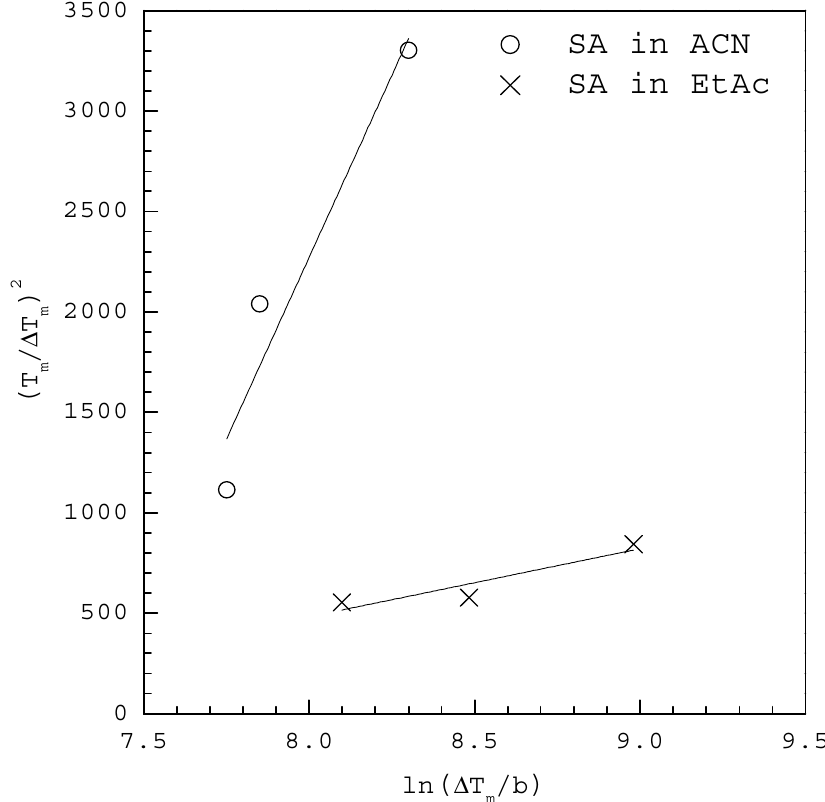
Figure 5. The MSZW data fitted to the linearized Equation (11) for SA in 20 mL ACN and EtAc saturated at T 0 = 323.15 K, where ∆ T m for each b is extracted at 50% of fraction detected nucleation events from the cumulative distributions of the MSZW data obtained by Mealey et al.